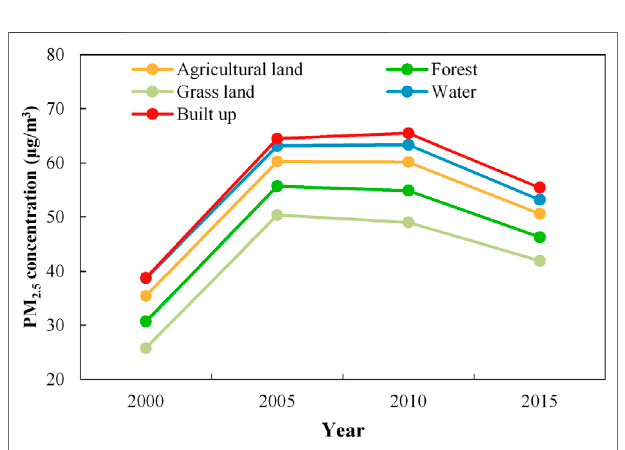
FIGURE 7 | Annually averaged PM 2.5 concentrations for different land